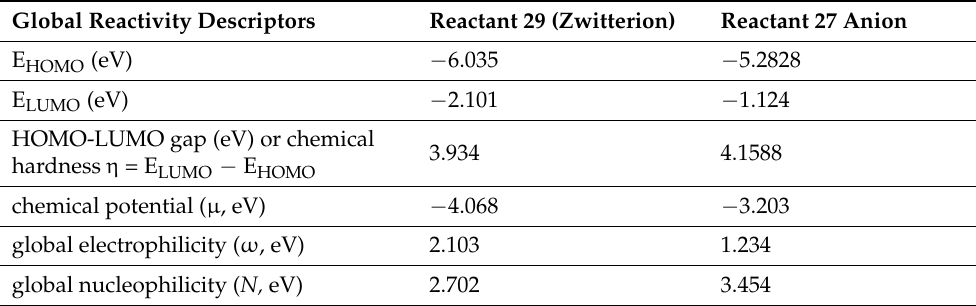
Table 3. Global reactivity descriptors of the individual reactants calculated at the B3YLP-D4/def2- TZVP in implicit ethanol as solvent. Energy units are in eV. The E HOMO for the reference compound tetracyanoethylene (TCE) is − 8.736 eV, computed at the same level. Global Reactivity